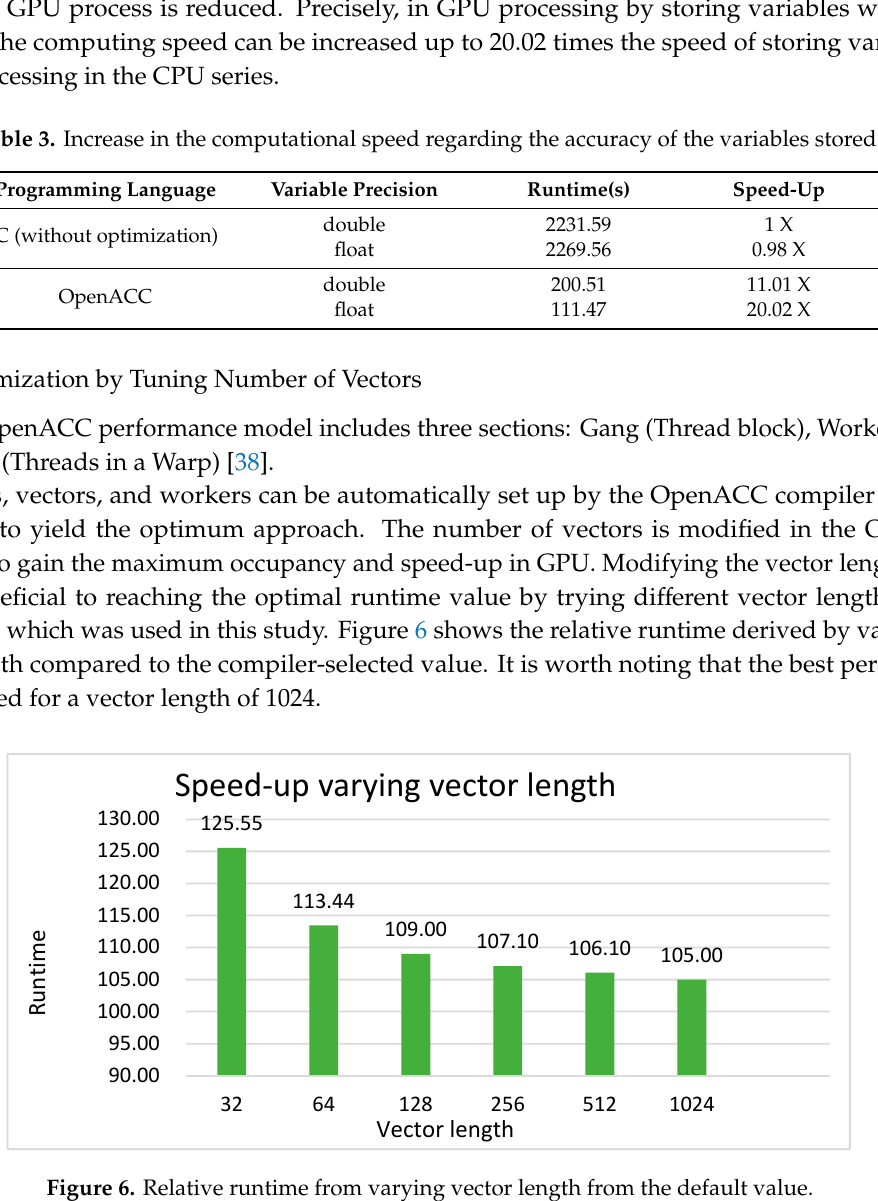
Figure 6. Relative runtime from varying vector length from the default value.